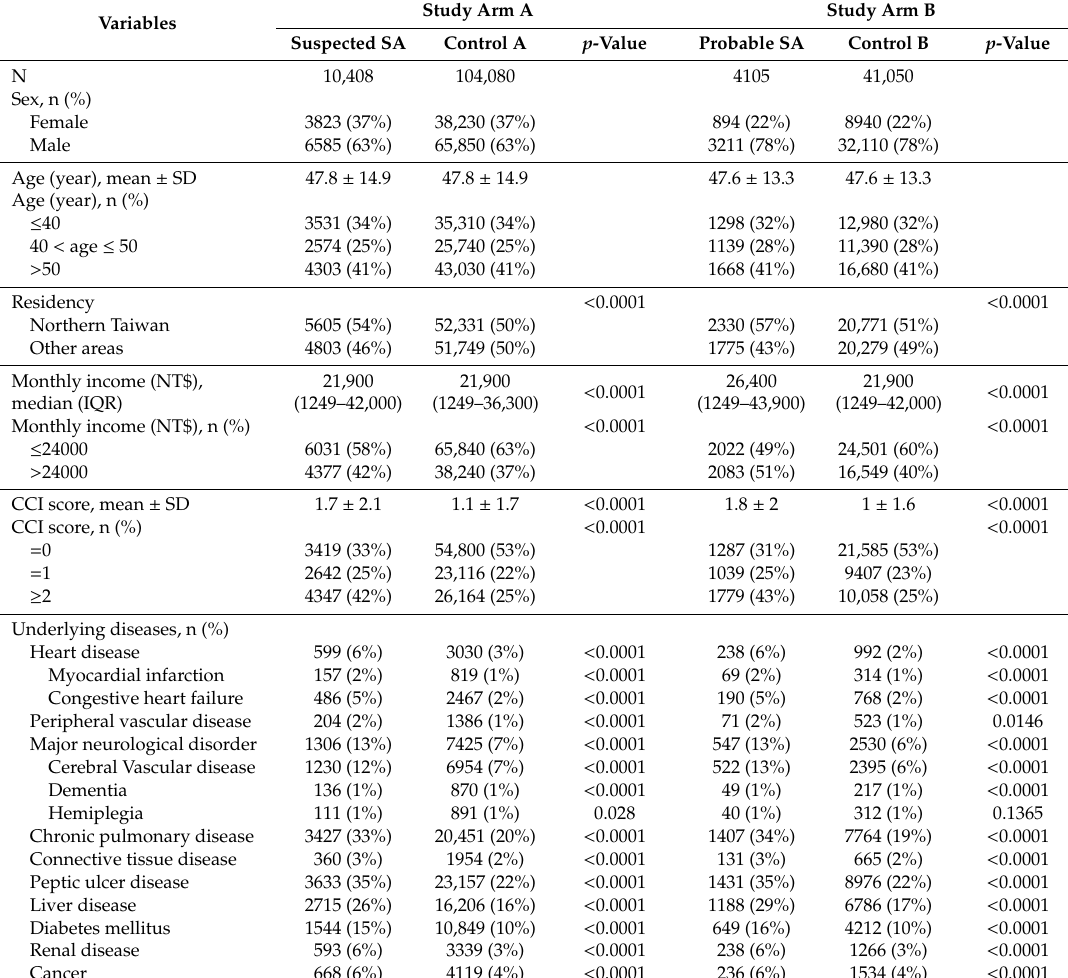
Table 1. Baseline characteristics of the study